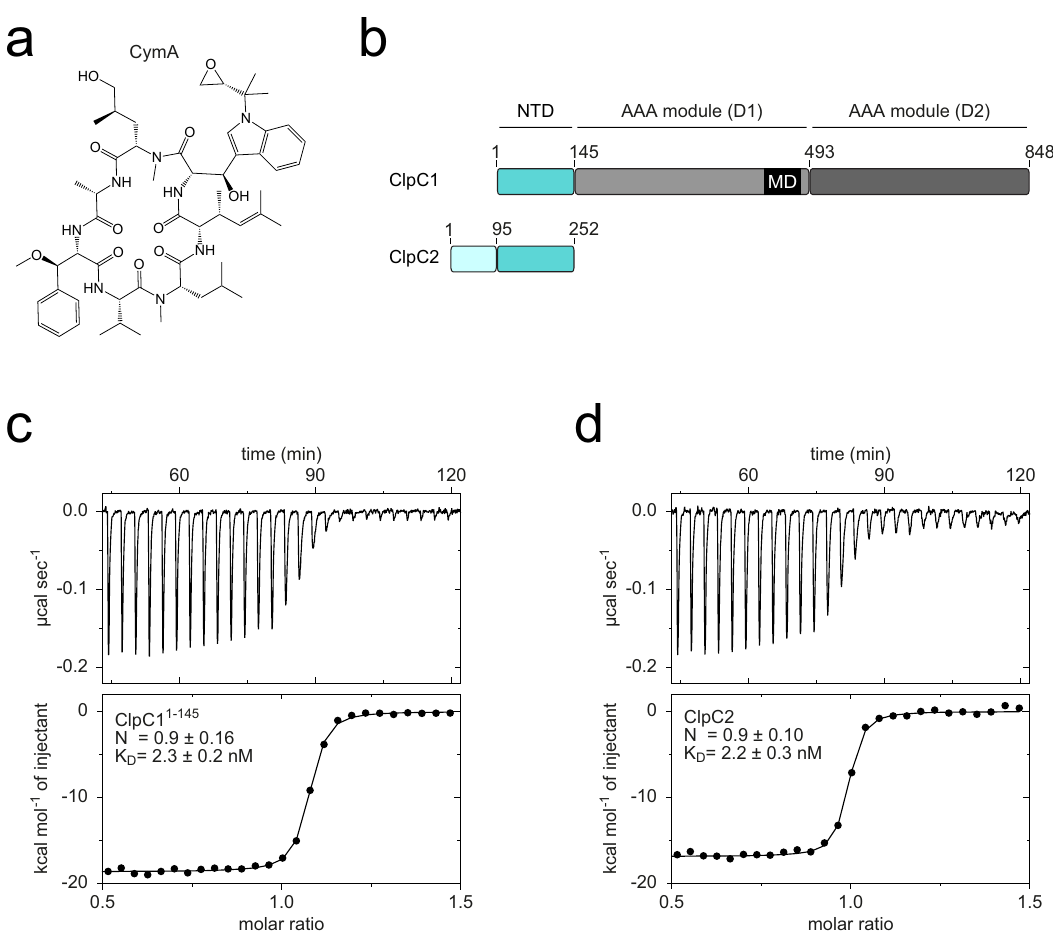
Fig. 1 The antitubercular compound CymA binds to Mtb ClpC2. a Structural formula of cyclomarin A (CymA). b Domain organisation of Mtb ClpC1 alongside its partial homologue ClpC2. ClpC1 NTD, N-terminal domain (cyan); AAA, ATPases Associated with diverse cellular Activities (shades of grey); MD, middle domain (black). The ClpC1 partial homologue, ClpC2, is coloured according to sequence homology to ClpC1 NTD: homologous region (cyan); non-homologous region (light blue). c , d Injection pro fi les and binding isotherms for ITC titrations of ClpC1 1 – 145 against CymA ( c ) and ClpC2 against CymA ( d ). The dissociation constant is indicated within each panel. Measurements were performed at 37 °C titrating aliquots of 50 μ M ClpC1 1 – 145 ( c ) or ClpC2 ( d ) to 5 μ M CymA. N and K D values are the mean ± standard deviation from three independent